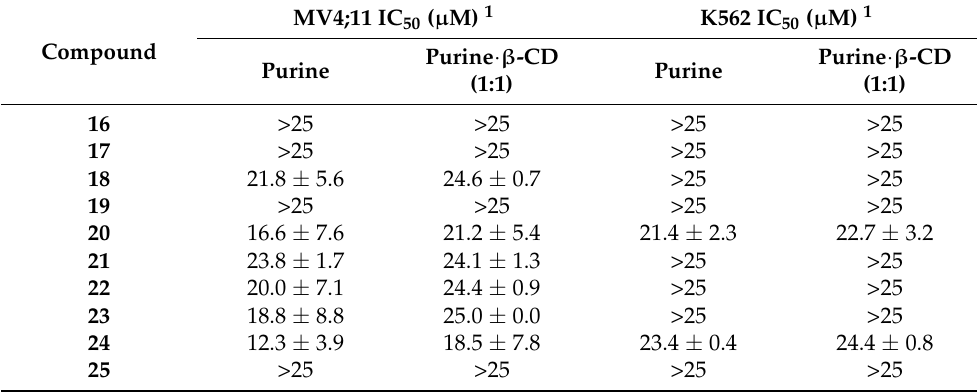
Table 1. In vitro antiproliferative activity of purines 16 – 25 and their complexes with β -CD. MV4;11 IC 50 ( µ M) Compound